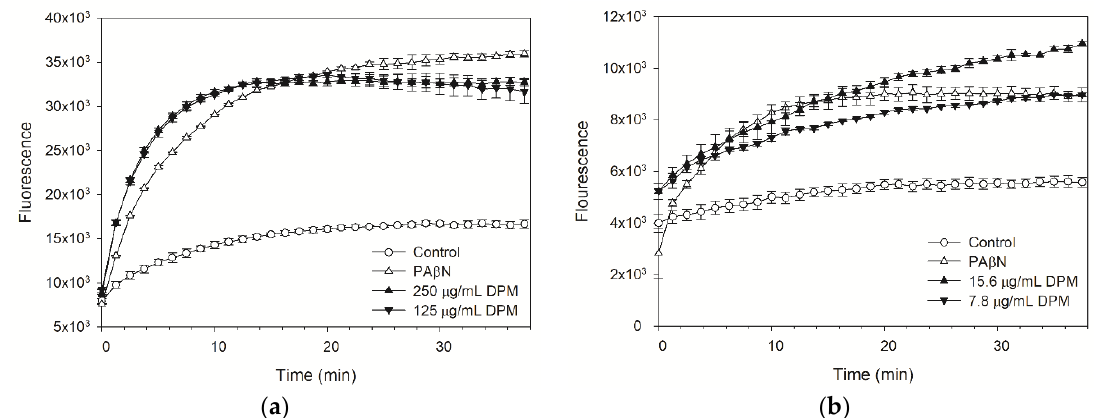
Figure 2. ( a ) H33342 and ( b ) EtBr accumulation of diphenylmethane in E. coli Kam3-AcrB. Data are expressed as mean ± SD ( n = 3).